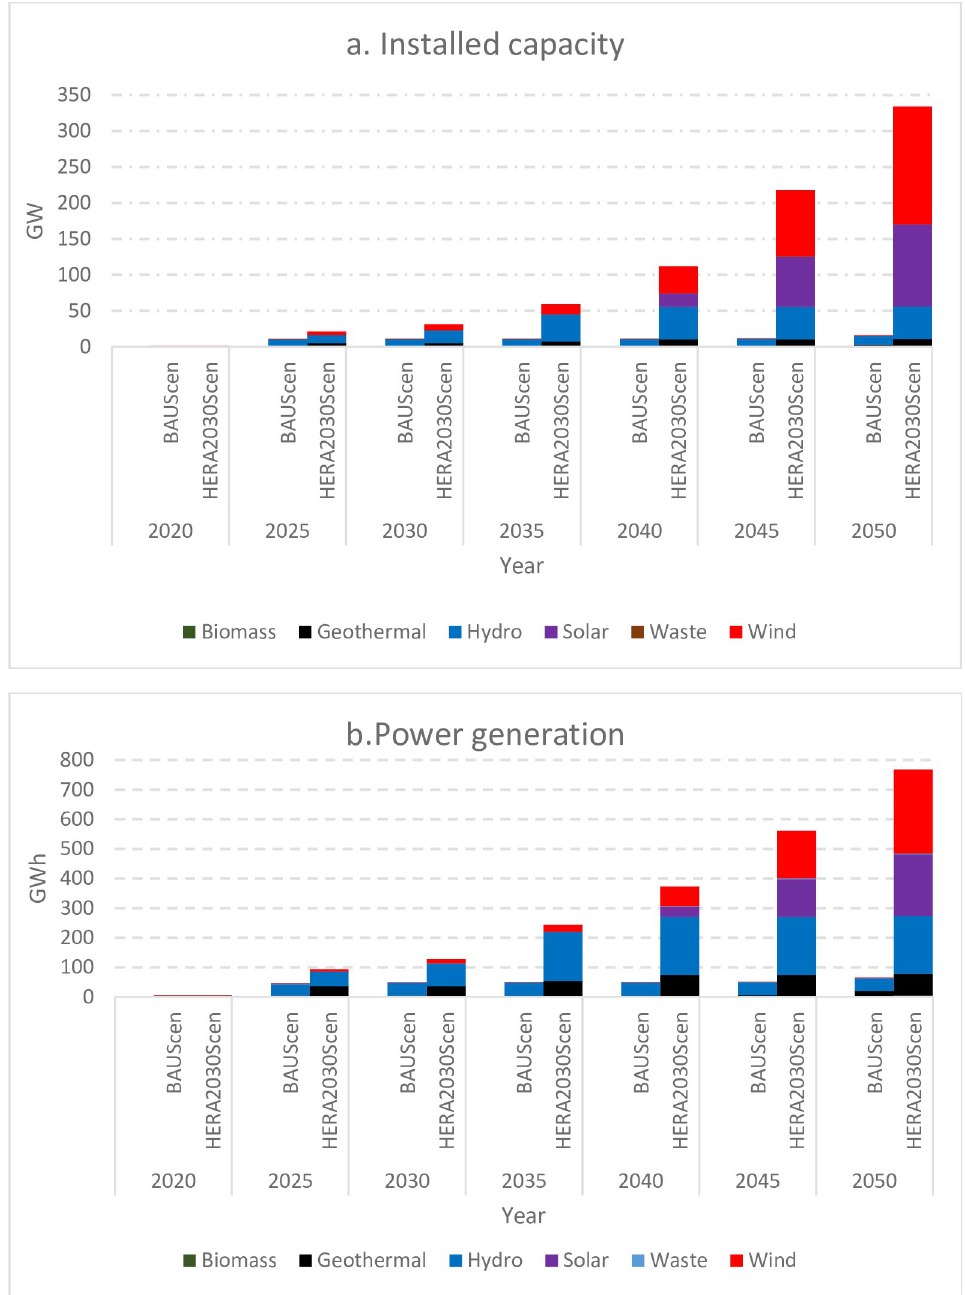
Fig 3. Least cost total installed capacity [a] and electricity generation [b] for the study period (2020–2050).